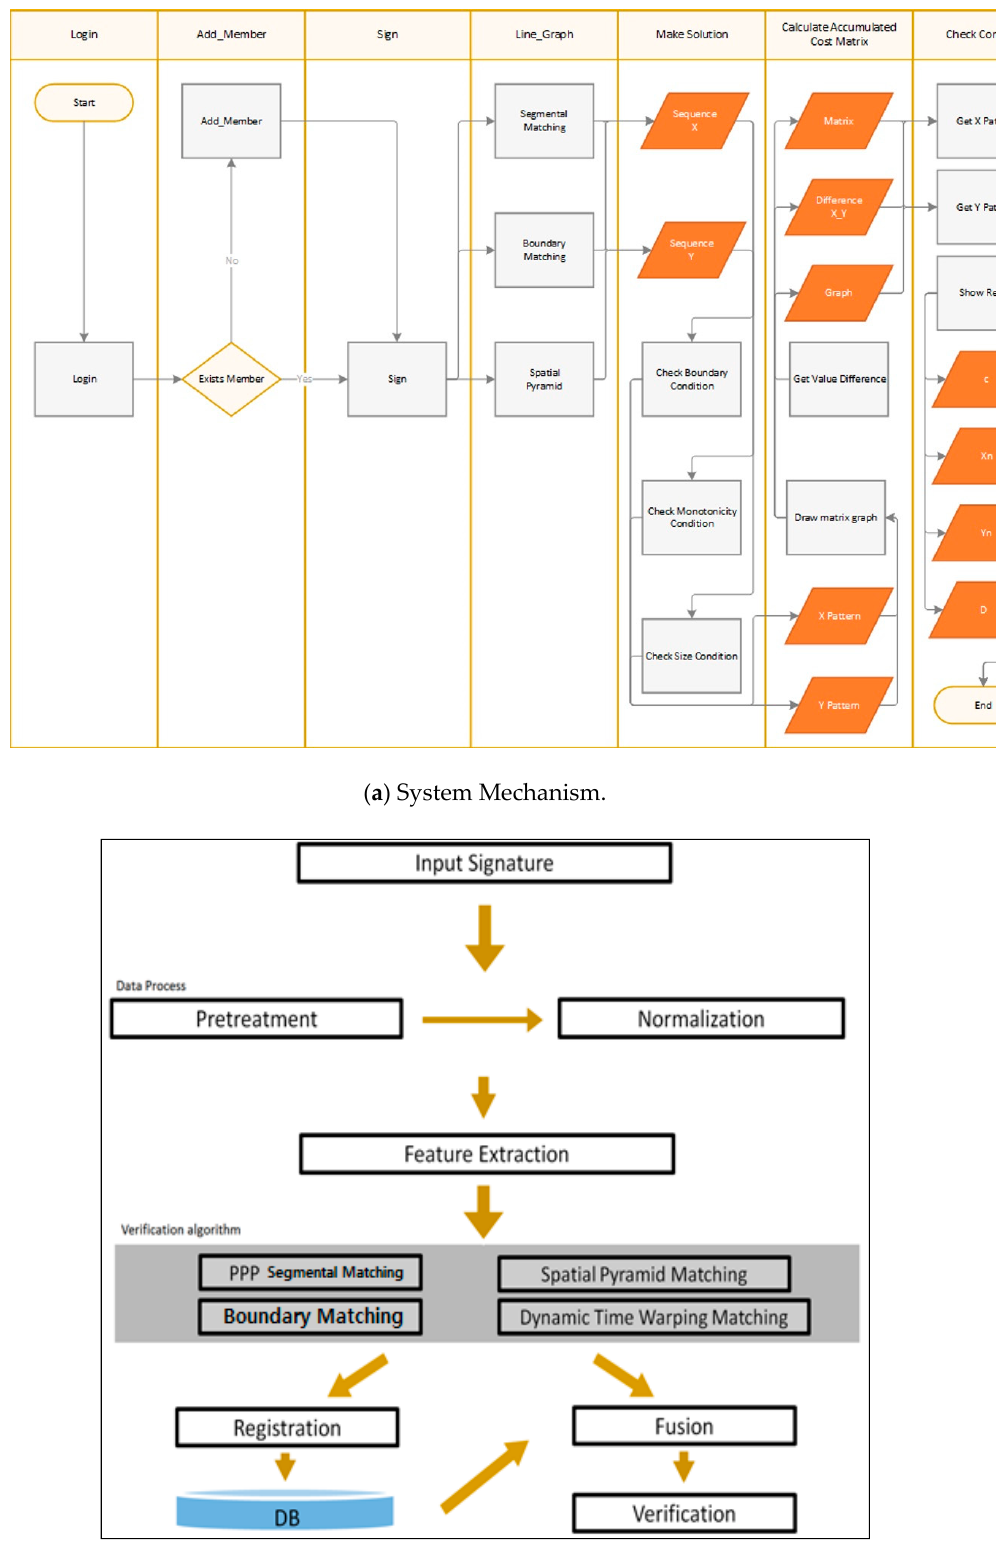
Figure 4. Overall system configuration.